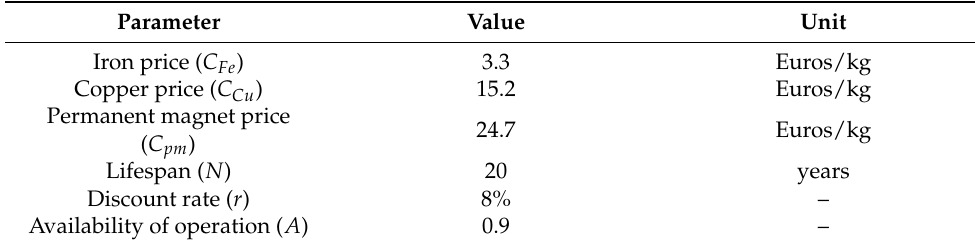
Table 3. Parameters in the economic modeling [14,48,49].